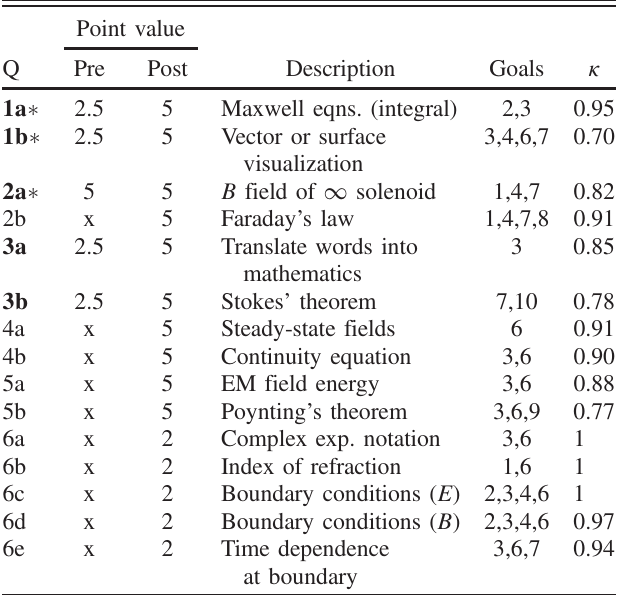
TABLE I. Summary of items on the CURrENT, including point allocations, associated learning goal(s), and Cohen ’ s κ ( N ¼ 90 ) (see Sec. IVon reliability). Question numbers in bold are also on the pretest; starred items are slightly modified in the pretest so as to remove reference to time